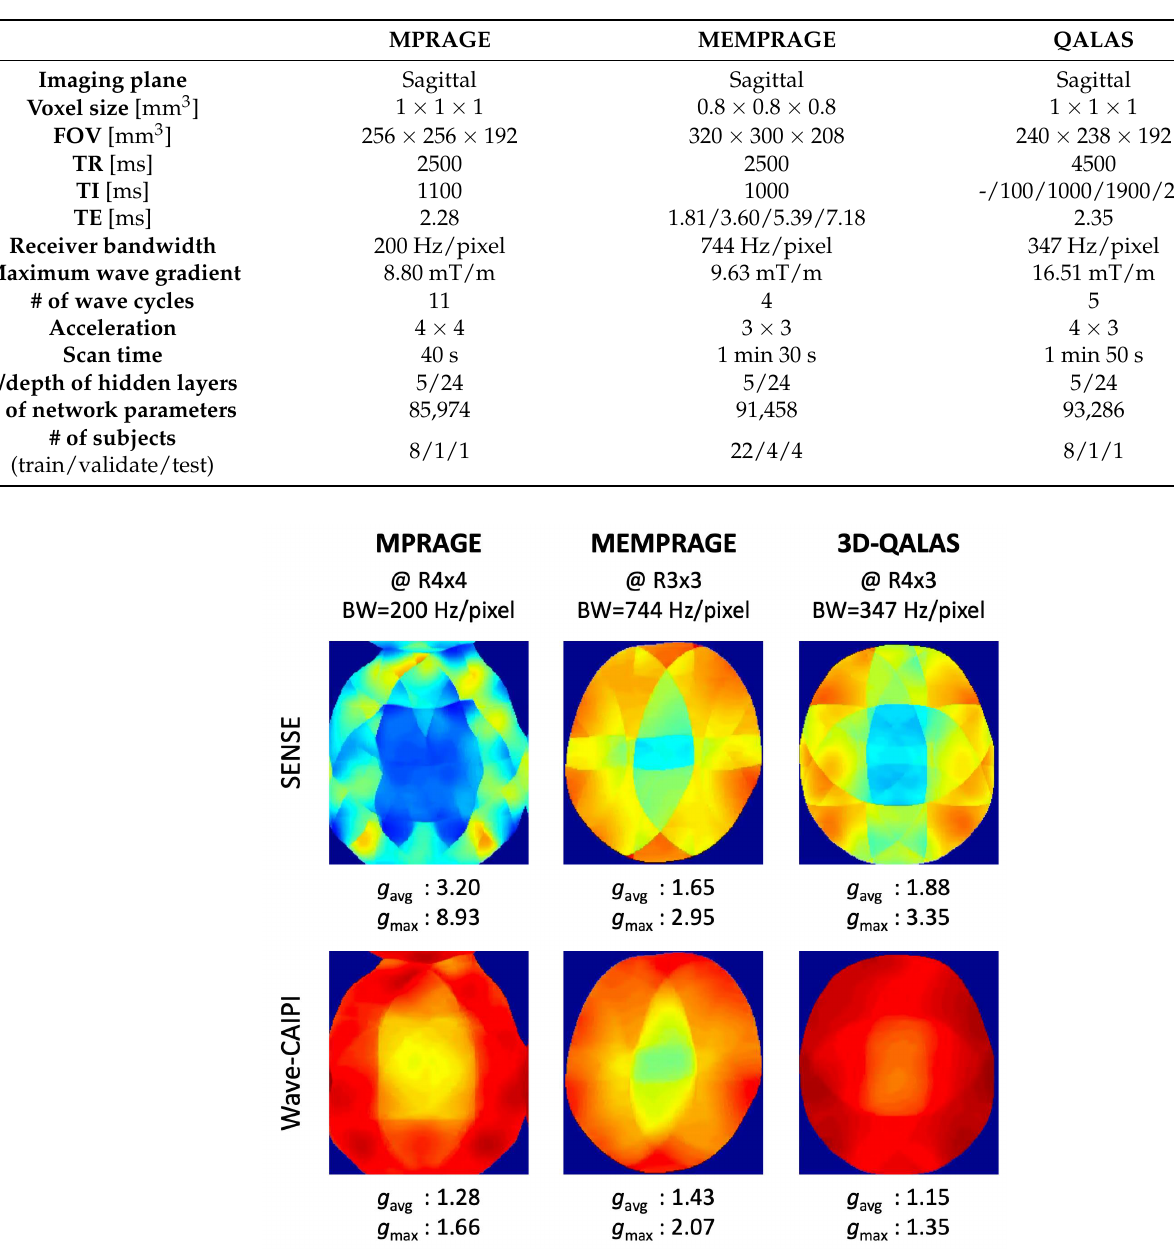
Table 1. Parameters of database and network parameters.